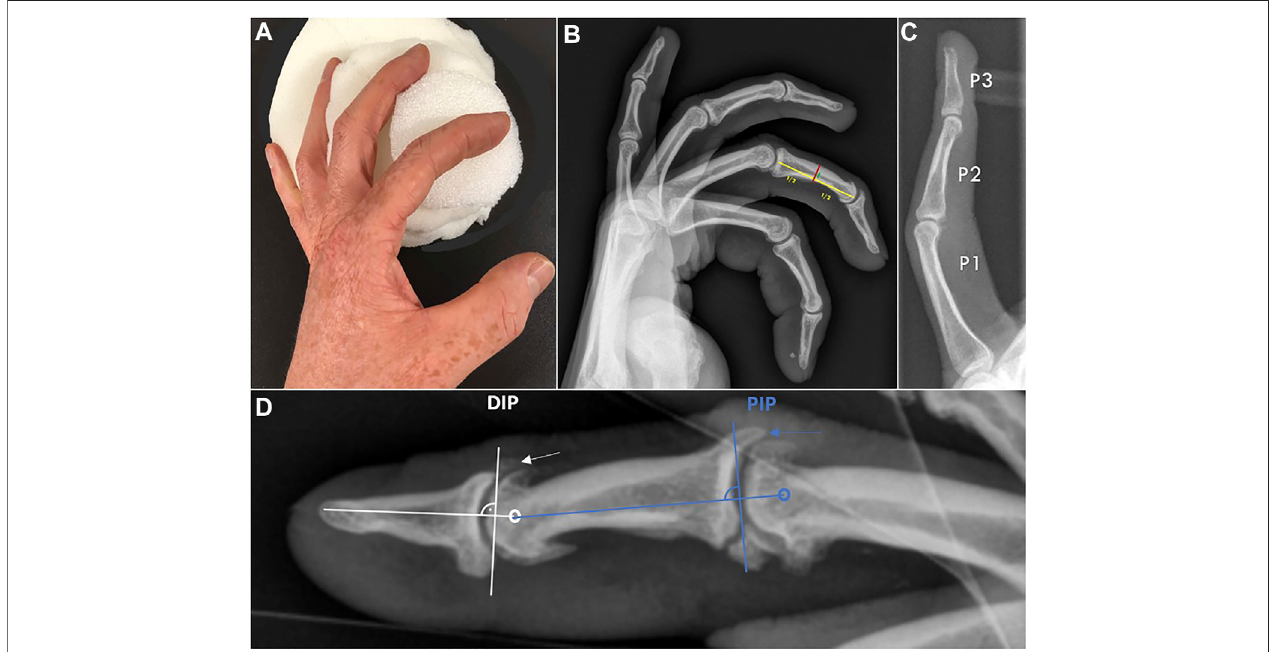
FIGURE 1 | (A) To obtain standardized lateral radiographs of all fi ngers, a custom-made device was used. (B) Climbers: lateral radiograph of a left hand using this device. Note how all fi ngers are projected strictly laterally and every single cortex is visible. Measurement of the intermediate phalanx of digit III is demonstrated as an example. Red line: outer cortical width. Green line: inner cortical width. Yellow line: length of the phalanx. (C) Controls: exemplary depicted lateral radiograph of a left middle fi nger. Note the clear differences in cortical thickness and medullary canal width in contrast to the climber. P1: proximal phalanx, P2: intermediate phalanx, P3: distal phalanx. (D) Lateral standardized radiograph of a left digit II in a climber. Modi fi ed measurement principles according to Allenspach et al. are demonstrated. Dorsal baseosteophyteswereratedaspresentorabsentat theDIPandPIPjoints,respectively. Thearrows markthepresenceofosteophytes